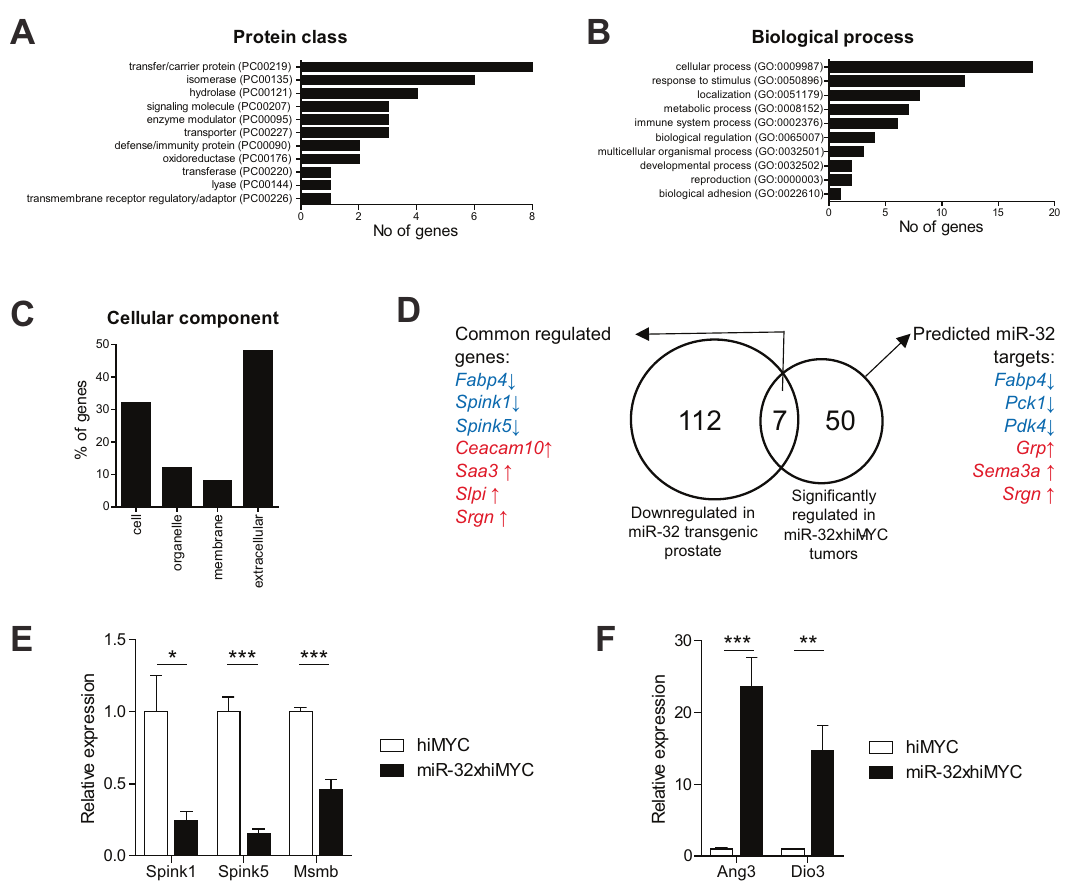
Fig. 3 Effects of transgenic miR-32 on gene expression in hiMYC-induced prostate cancer in mice. Gene expression analysis was performed on miR-32xhiMYC compared to hiMYC mouse tumorous prostates at 6 months of age. A Protein class distribution, B biological processes, and C cellular component of genes differentially expressed in miR-32xhiMYC compared to hiMYC mice. D Venn diagram showing common genes between genes downregulated in mouse prostate by transgenic miR-32 expression from a previous study [29] and genes differentially expressed in tumorous mouse prostates of miR-32xhiMYC compared to hiMYC mice in this study. The identi fi ed commonly regulated genes are shown, as well as genes that are predicted or veri fi ed targets for miR-32 among the differentially expressed genes in miR-32xhiMYC compared to hiMYC mice in tumorous prostates. E RT-qPCR validation of genes downregulated by transgenic miR-32 expression. F RT-qPCR validation of genes upregulated by transgenic miR-32